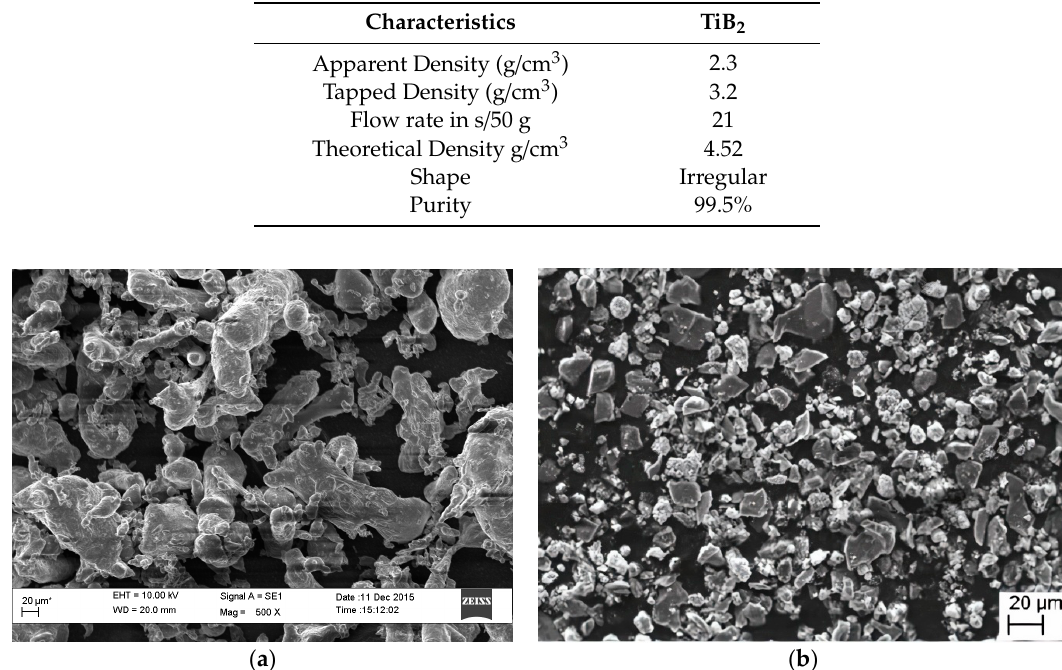
Figure 1. Morphology of the as-received powders. ( a ) Al 6061, ( b ) TiB 2. Table 1. Powder characteristics of the as received Al-6061.